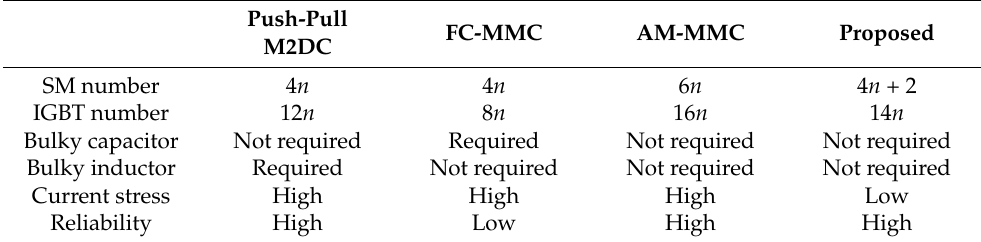
Table 2. Comparison of the existing DC-DC MMC when r =